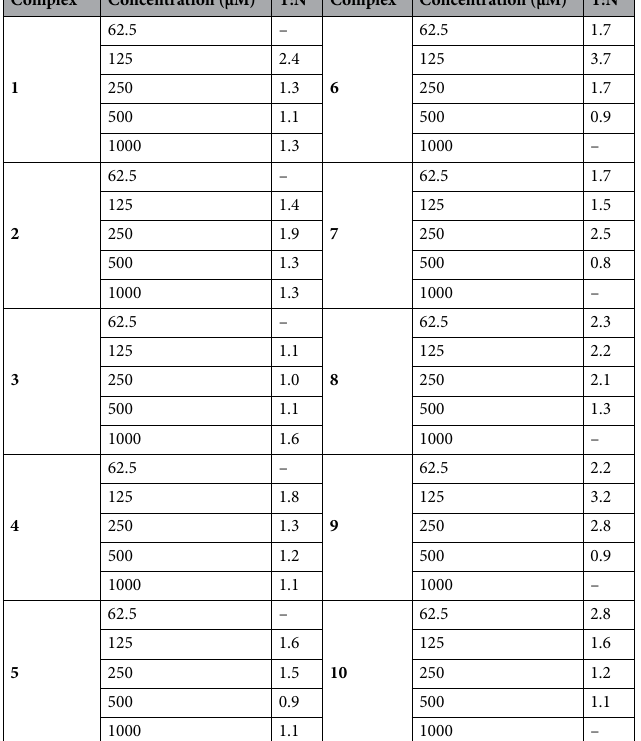
Table 4. Tumour-to-normal (T:N) cell ratios for complexes 1 – 10 .